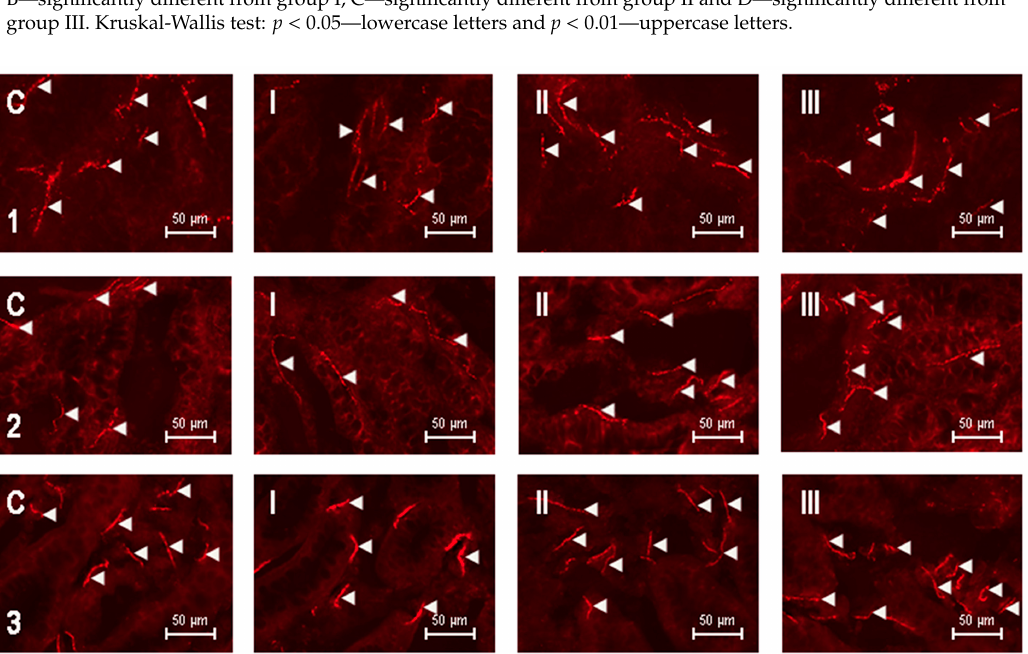
Figure 1. Vasoactive intestinal polypeptide (VIP)—positive nerves (indicated with arrowheads) in the mucosal layer of the canine digestive tract: 1 —duodenum, 2 —jejunum, 3 —descending colon, C —control dogs, I —dogs with mild inflammatory bowel disease (IBD), II —dogs with moderate IBD and III —dogs with severe